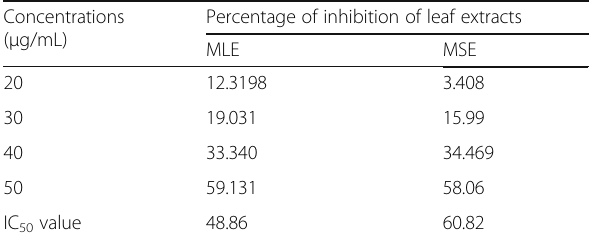
Table 4 Effect of leaf extracts of B. lupulina in DPPH antioxidant model